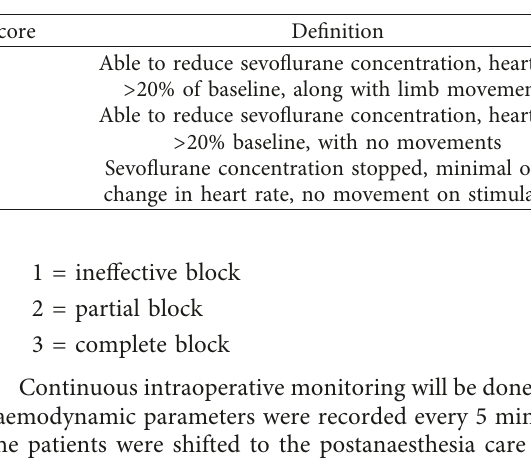
Table 1: Caudal effectiveness